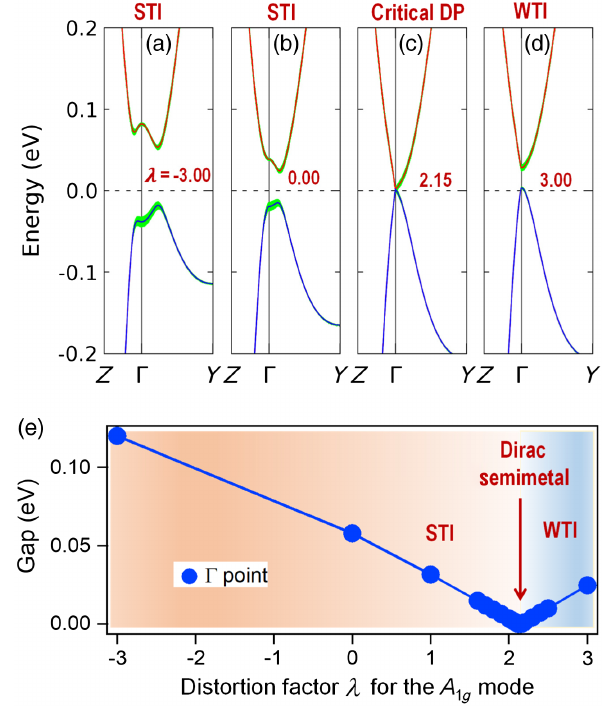
FIG. 4. Electronic band structure calculations for the topologi- cal phase switching via excitation of the A 1 phonon mode in g ZrTe 5 . The band structure along Z − Γ − Y for different magni- tudes of the lattice distortion factor λ corresponding to the A 1 g mode [see Fig. 1(c)]: (a) − 3 . 00 , (b) 0.00, (c) 2.15, and (d) 3.00. For λ ¼ 1 . 0 , the corresponding atomic displacements for the A 1 g mode are 0.033 Å for Zr, Te , and Te , and 0.017 Å for Te . The d a z p orbitals denoting green shadow indicates the projection of Te d band inversion. This procedure identifies the states with λ ¼ − 3 . 00 , 0.00 (a),(b) as STI having a topological index of (1;110), whereas the critical Dirac point occurs for λ ¼ 2 . 15 (c). Absence of band inversion for λ ¼ 3 . 00 (d) indicates a WTI with the topological index (0;110). (e) Energy gap at the Γ point as calculated from the band structure as a function of the atomic displacement magnitudes λ